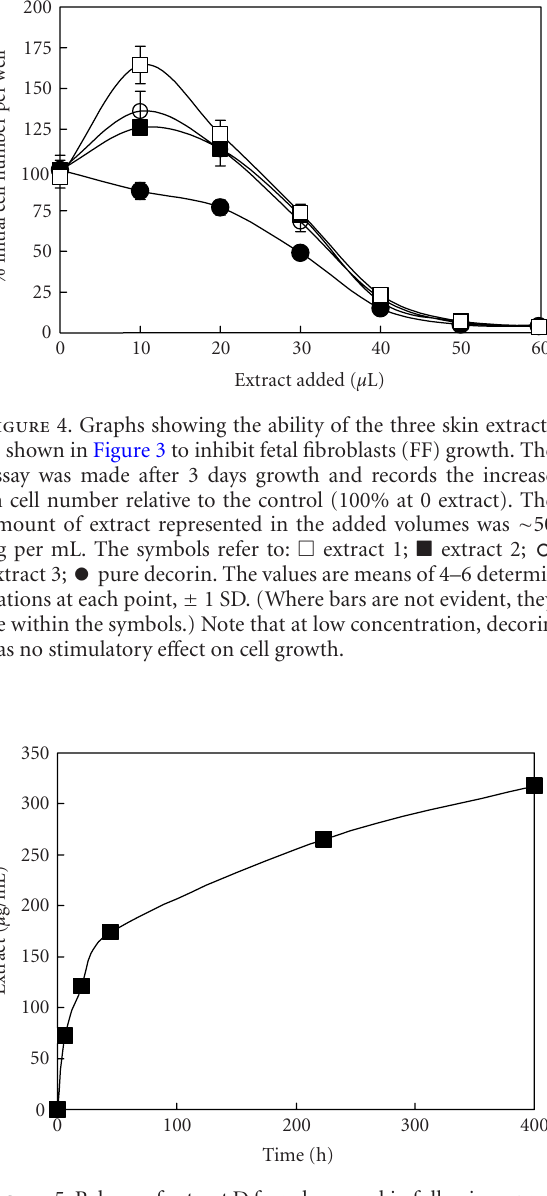
Figure 5. Release of extract D from human skin following a pro- longed incubation with a single batch of the citrate bu ff er. The curve demonstrates the protein recovery, which is related closely with its antifibroblast activity. More than half the maximal ex- traction at 400 hours was achieved within the first 60 hours. Time points are single values taken from a single extraction pro- cedure.